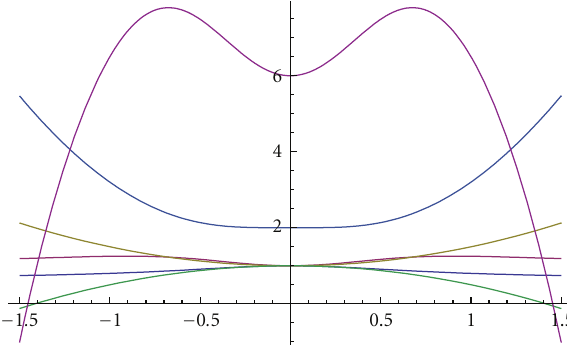
Figure 2: Plot of the six conditions Q i and c i derived previously, as a function x . Here γ = 1. Allowed values for the field velocity are typically | x | < O ( γ − 1 / 2 ), as made clear by drawing similar plots while varying γ .